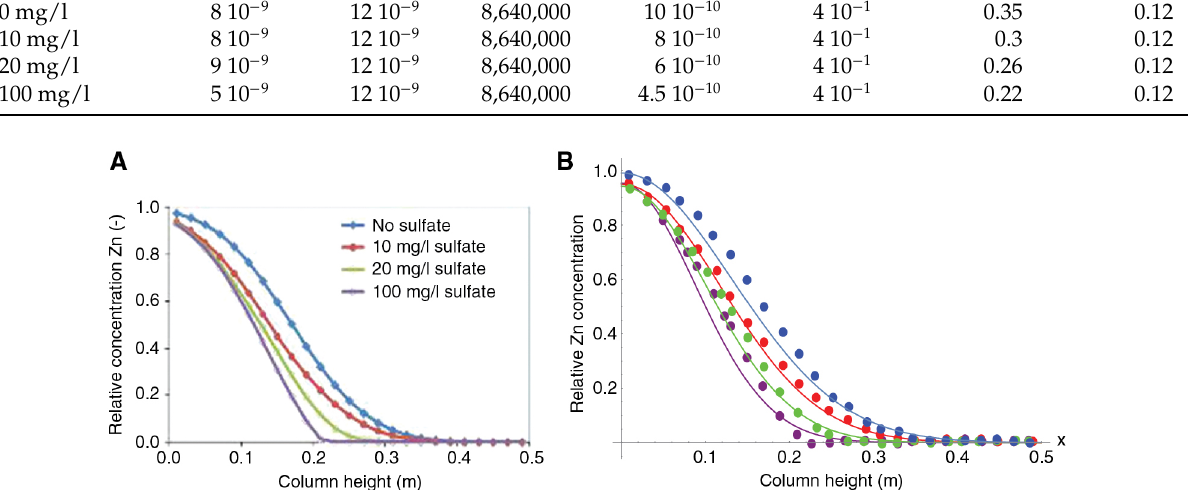
Figure 3: (A) Zn removal profile after 100 days in case of sulfate intrusion. (B) Comparison between theoretical predic- tions and simulation results [22].